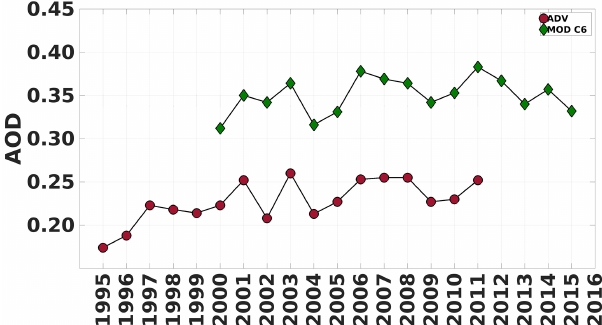
Figure 12. Time series of ATSR- and MODIS-retrieved AOD over China for two decades: 1995–2015. Note that data are missing in the beginning of the ATSR-2 observation period in 1995, and also MODIS/Terra data are available starting in April 2000; AATSR data start in May 2002. Therefore, the ATSR-2 1995 data point includes data for June–December and for 1996 July–December. ATSR-2 was used from 1995 to July 2002; for August 2002 to 2011 AATSR data were used. AATSR for 2012 is not shown since only 3 months of data are available, mainly in the winter (January–February–March) with low coverage. The MODIS 2000 data point includes data from April to